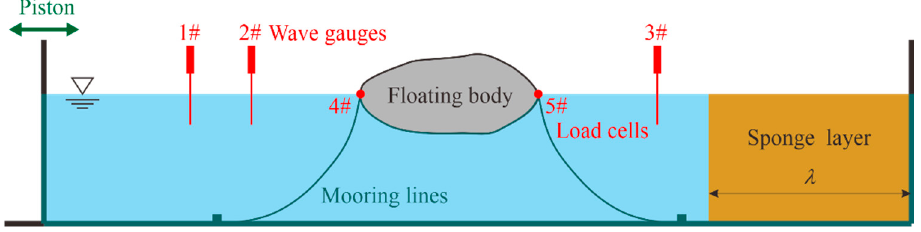
Figure 3. Numerical wave flume used to simulate the interaction between waves and mooring floating bodies.